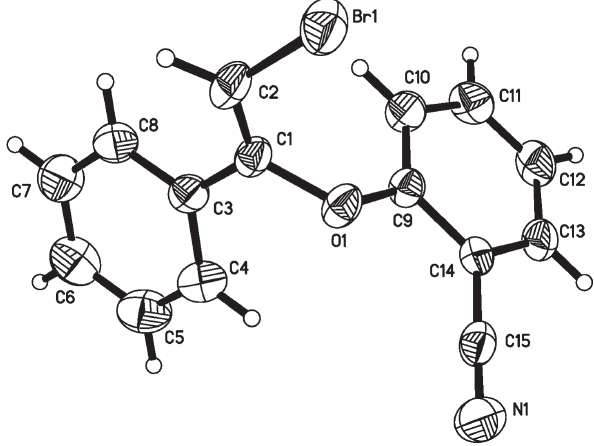
Table 1: Data collection and handling.